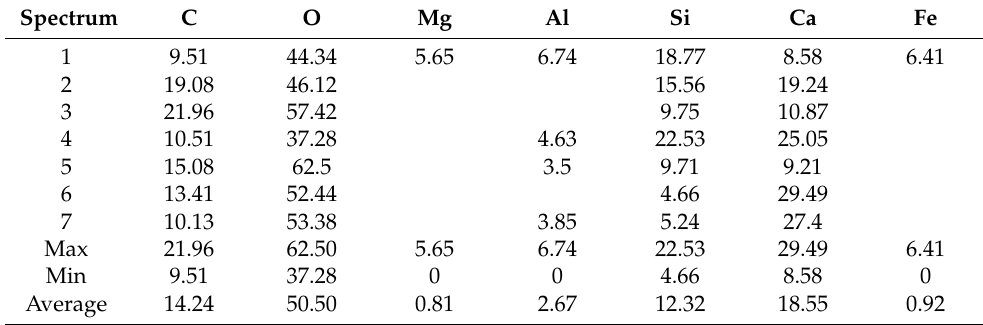
Table 5. Element mass percentage content of the carbonation layer in group HA (wt%).